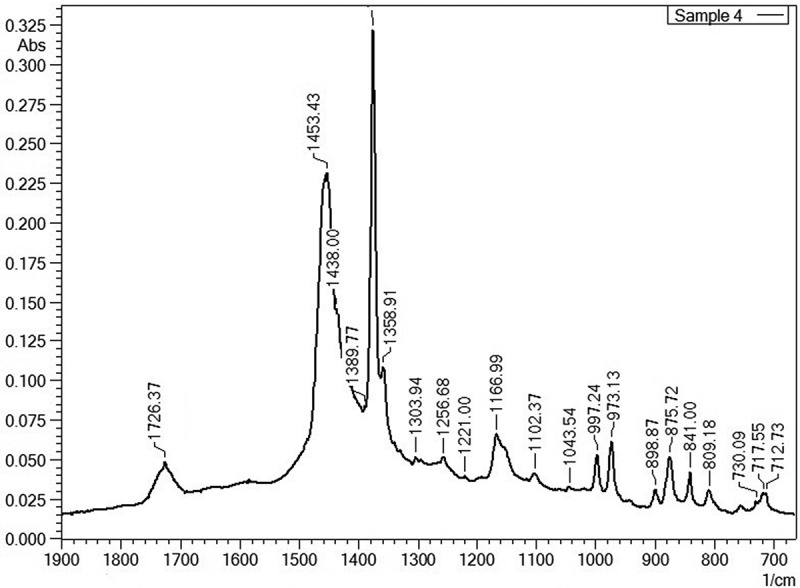
FTIR spectrum from sample 4 showing peaks from CaCO3 (at 712.73 and 875.72 cm−1) and PP/PE as the main matrix (at 717.55, 809.18, 841.00, 898.87, 973.13, 997.24, 1043.54, 1102.37, 1166.99, 1221.00, 1256.68, 1303.94, 1354.91, 1389.77, 1438.00 and 1453.43 cm−1) with an ester peak probably from PBT or PET (at 1726.37 cm−1). The peak at 730.09 cm−1 represents residual toluene from the sample extraction step for removal of BFRs.